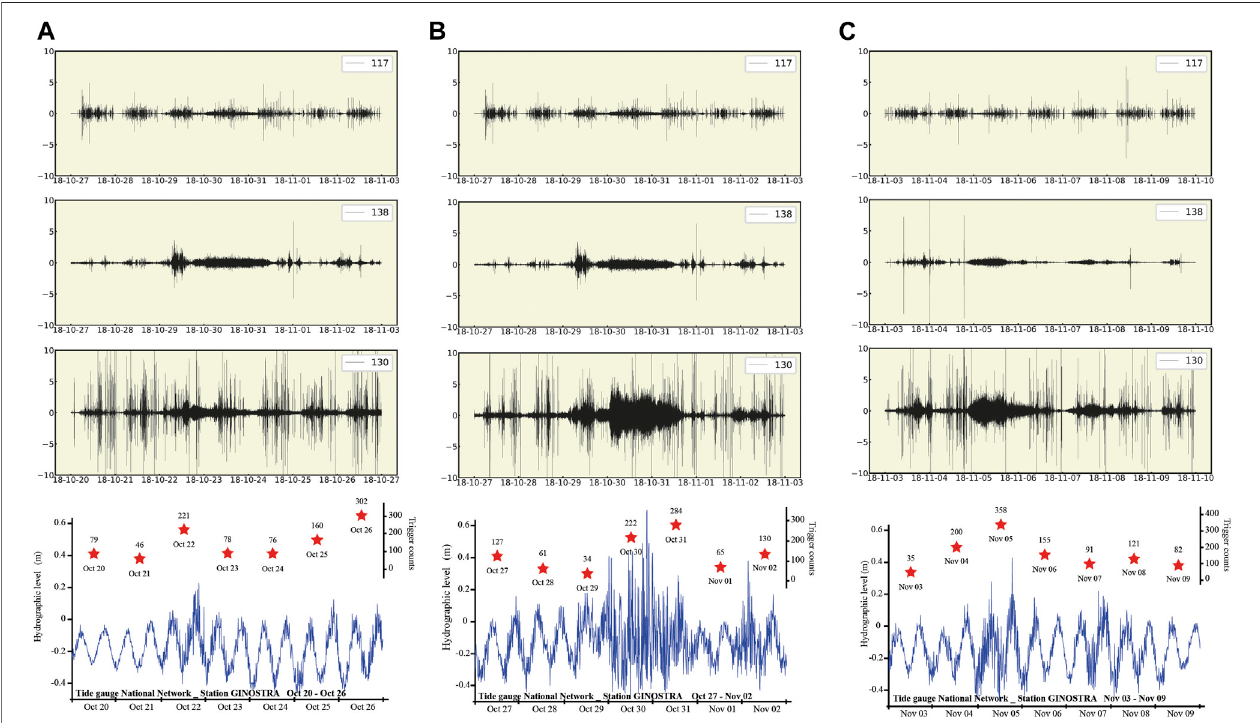
FIGURE 6 | Plots of seismic signal at three different nodes (117, 138 and 130) and height of the sea wave at the tide gauge of Ginostra (ISTR) (https://www. mareogra fi co.it) forthree-time intervalsin2018: (A) 20to26October2018; (B) 27Octoberto2November 2018; (C) 3to9November 2018.Red starsindicate thedaily trigger counts recorded during each period. See text for